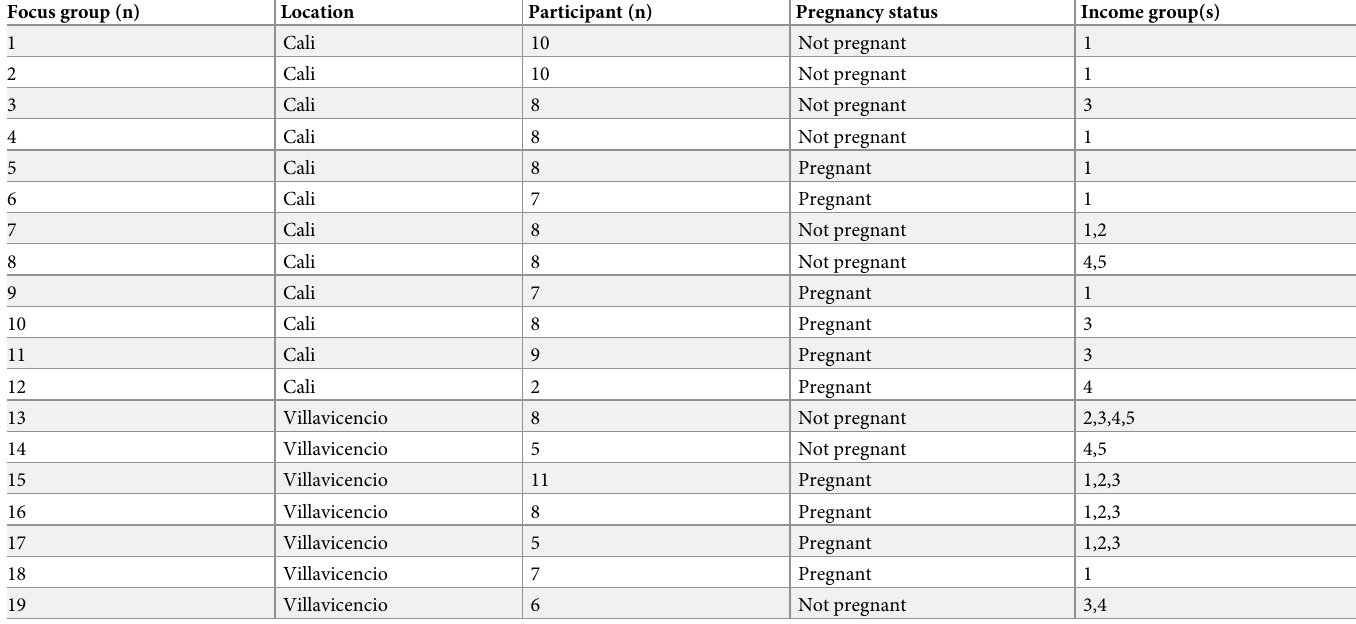
Table 1. Focus group composition. Income group uses a scale from 1–6, where 1 and 2 are low, 3 and 4 are middle and 5 and 6 are high—according to the Colombian “estratos socioeconomicos” (socioeconomical strata) criteria. Focus group (n) Location Income